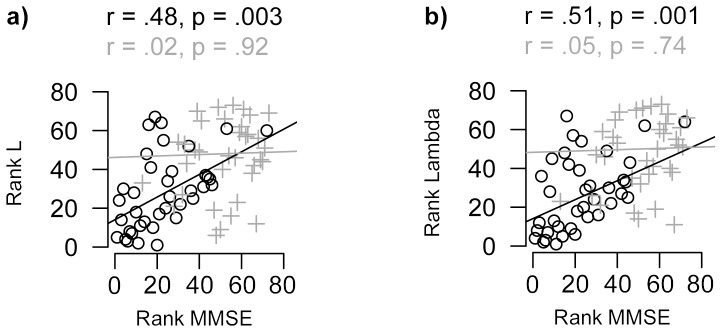
Scatter plots of rank-transformed scores on the mini-mental state examination (MMSE) with global path length L and λ.Correlations between MMSE and L (a) and λ (norm. L.; b) for the AD (black circles) and control group (dark grey plus signs). Note that global grey matter volume, graph size and connectivity density were unrelated to MMSE scores (resp. r = −0.18, p = 0.28; r = −0.18, p = 0.29; r = −0.06, p = 0.73), nor were such relationships found with local grey matter in any of the AAL regions.